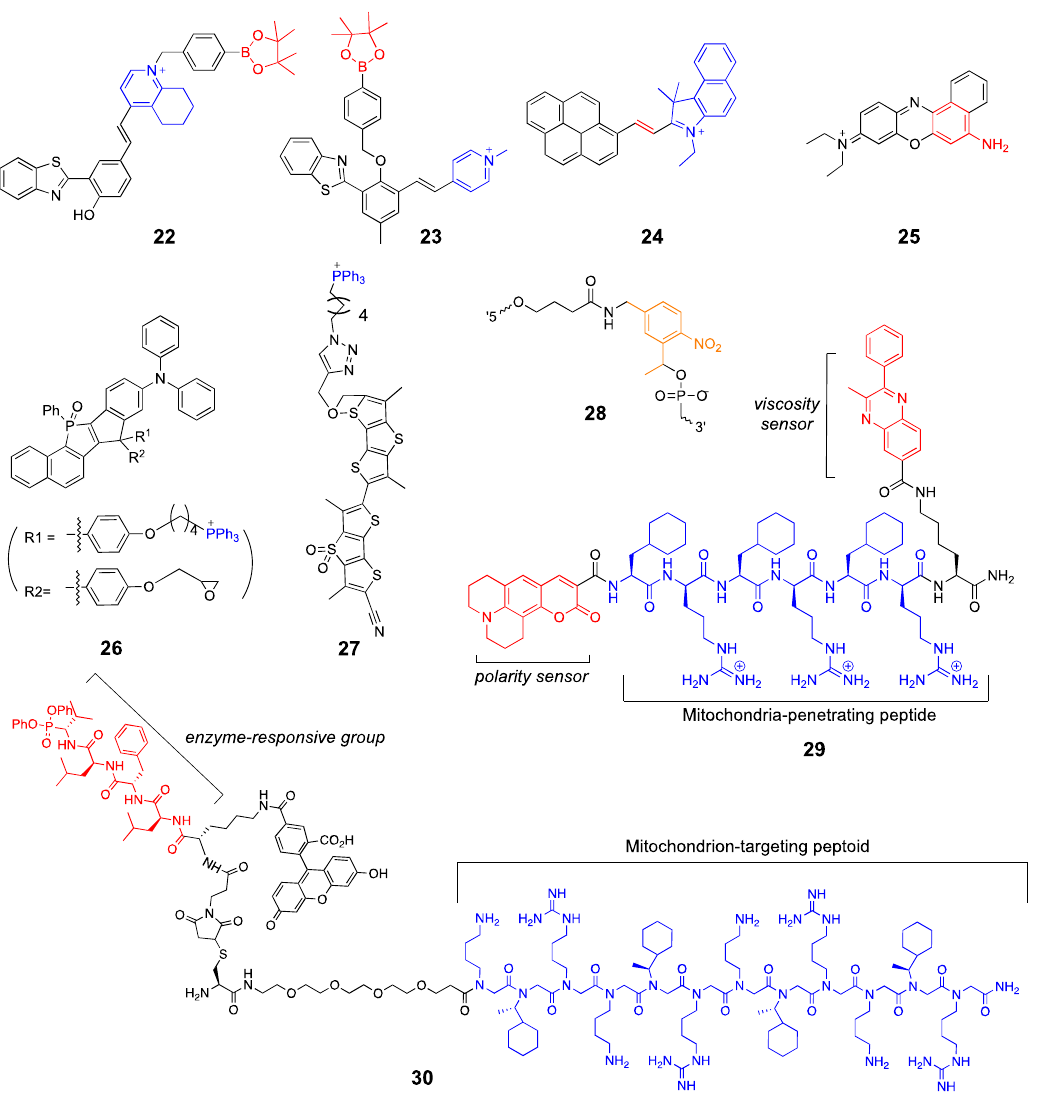
Figure 7. Mitochondrion-targeted probes (blue: targeting moiety; red: responsive moiety; orange: photocaging group).